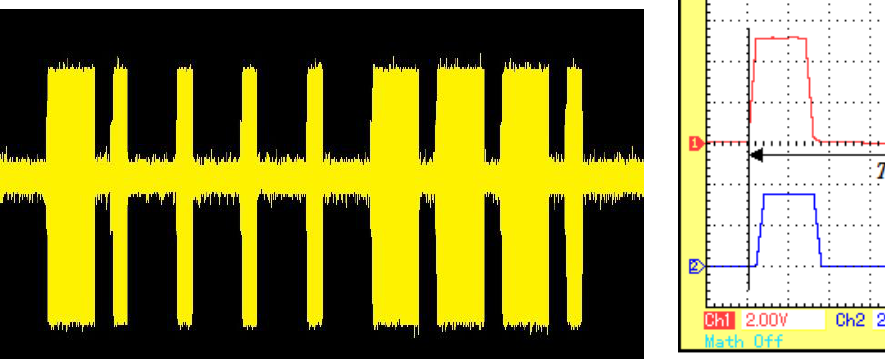
Figura 5: Sinal modulado capturado por indução. Fonte: Autores, (2018).